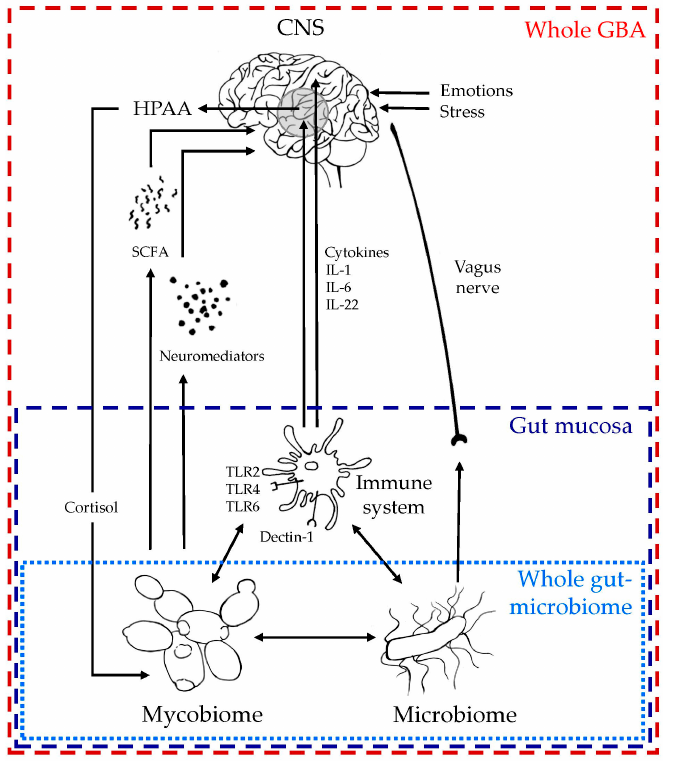
Figure 1. Proposed mechanisms of communication between the gut mycobiome and GBA. Figure inspired from [38,95]; for details about fungi–immune system interactions see review [49,96]. Abbreviations: CNS: central nervous system, GBA: gut–brain axis, HPAA: hypothalamic–pituitary–adrenal axis, IL: interleukin, SCFA: short chain fatty acid, TLR: Toll-like